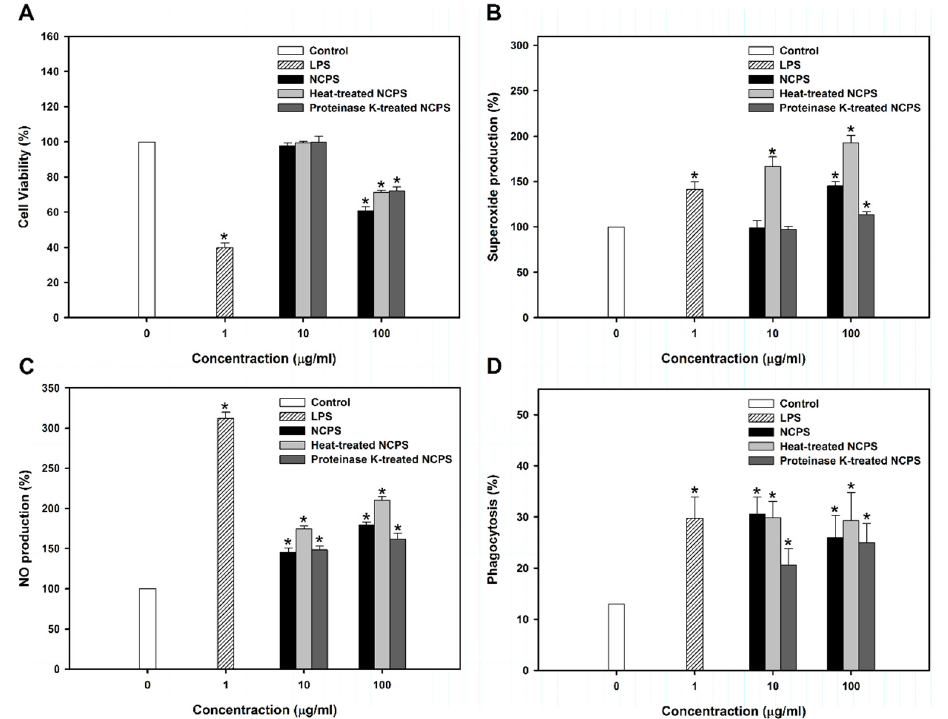
Figure 4. Cell viability ( A ), superoxide production ( B ), nitric oxide synthesis ( C ), and phagocytosis ( D ) of RAW264.7 cells upon treatment with NCPS for two days. * indicates that there is a statistically significant difference between control and treatment groups ( p <